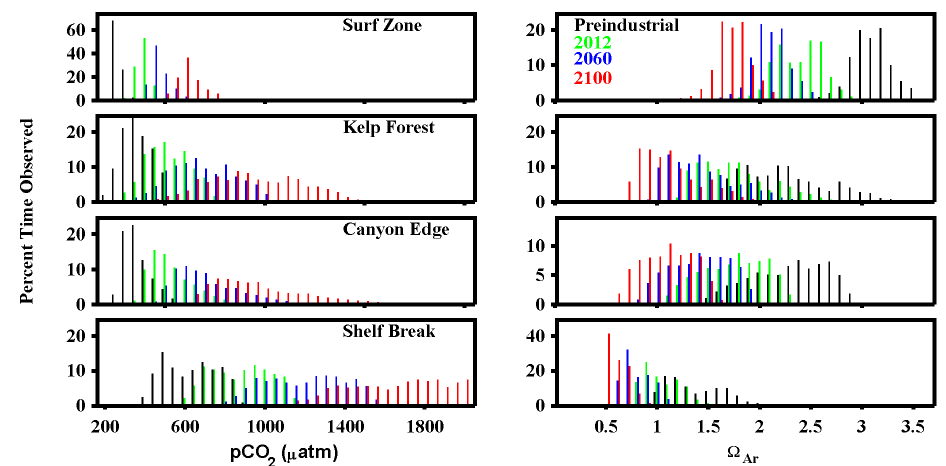
Figure 11. Histogram of modeled p CO 2 (left) and (cid:127) Ar (right) distribution at the four depths for preindustrial (black), 2012 (green), 2060 (blue), and 2100 (red). Atmospheric p CO 2 for the years 2060 and 2100 roughly corresponds to 510 and 670µatm based on the IPCC RCP6.0 scenario.